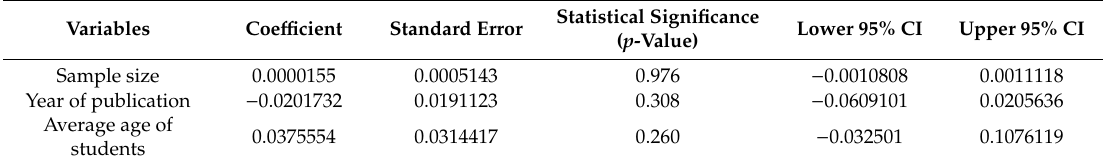
Table 2. Meta-regression analyses based on sample size, year of publication and average age of students. No statistically significant e ff ects could be detected.